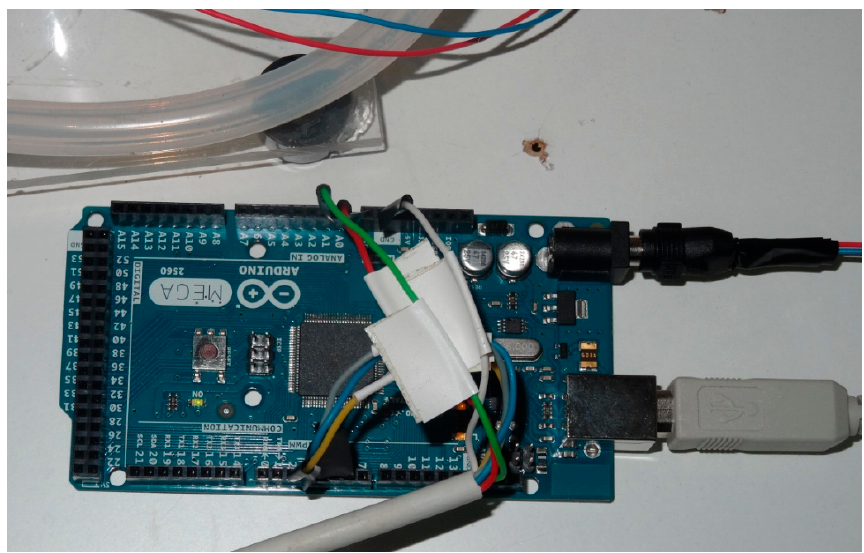
Figure 11. Arduino MEGA connected under laboratory tests.